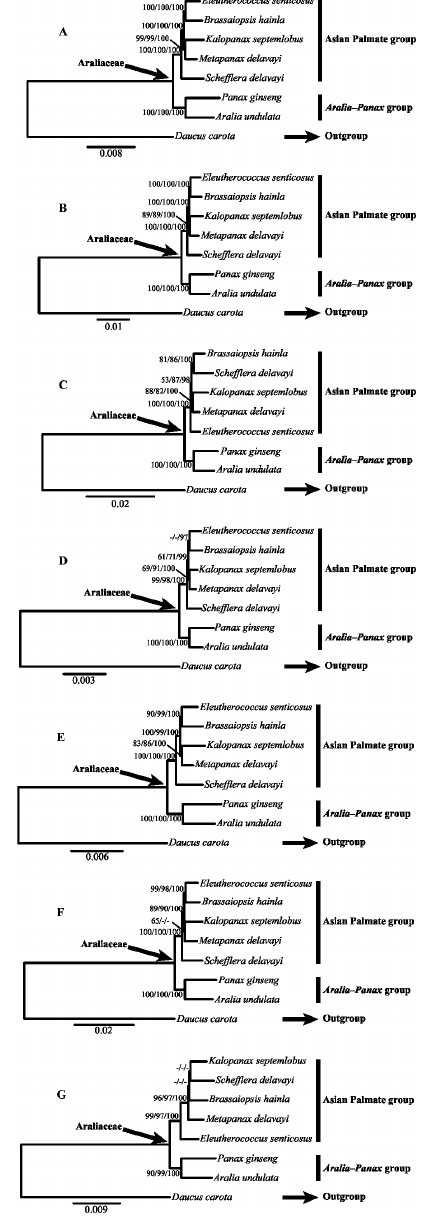
Figure 5. Phylogenetic relationships of Araliaceae based on seven different data partitions in chloroplast genomes. A: Complete chloroplast DNA sequences; B: The large single-copy (LSC) region; C: The small single-copy (SSC) region; D: The inverted repeat (IR) region; E: Eighty common protein coding genes; F: The intergenic spacers region; G: The introns region. Support values are shown for nodes as maximum parsimony bootstrap (PB)/maximum likelihood bootstrap (LB)/Bayesian inference posterior probability (PP). Dash shows that the PB value lower than 50% or the LB value lower than 70% or the PP value lower than 0.95. Branch lengths were calculated through Bayesian analysis, and scale bar denotes substitutions per site. doi: